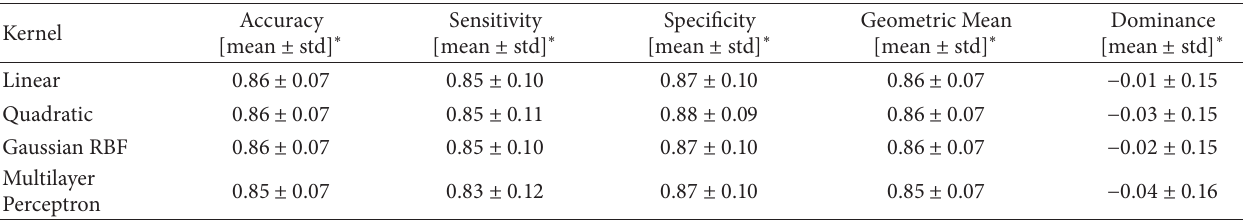
Table 4: Performance of ML (accuracy, sensitivity, specificity, GM, and Dominance) in the classification of CDR = 0.5 versus CDR = 0 using linear, quadratic, Gaussian RBF, and Multilayer Perceptron kernels. Results were obtained using the computation-based feature reduction. Kernel